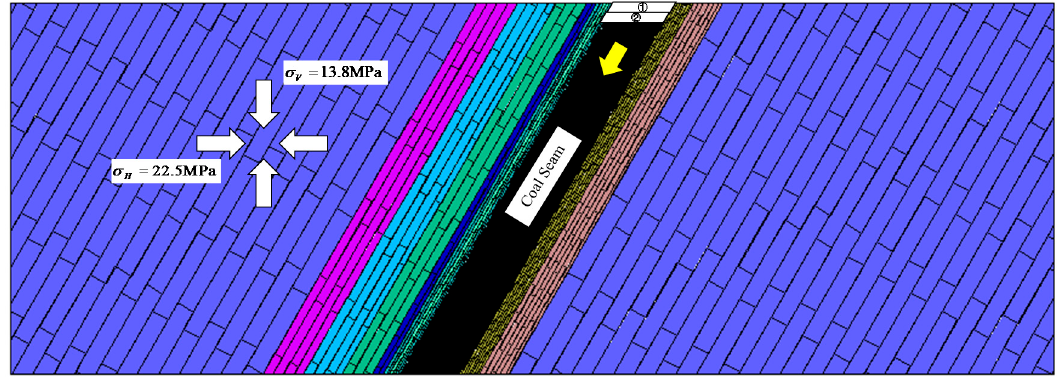
Figure 6. In situ stress and excavation procedures adopted in the UDEC model.